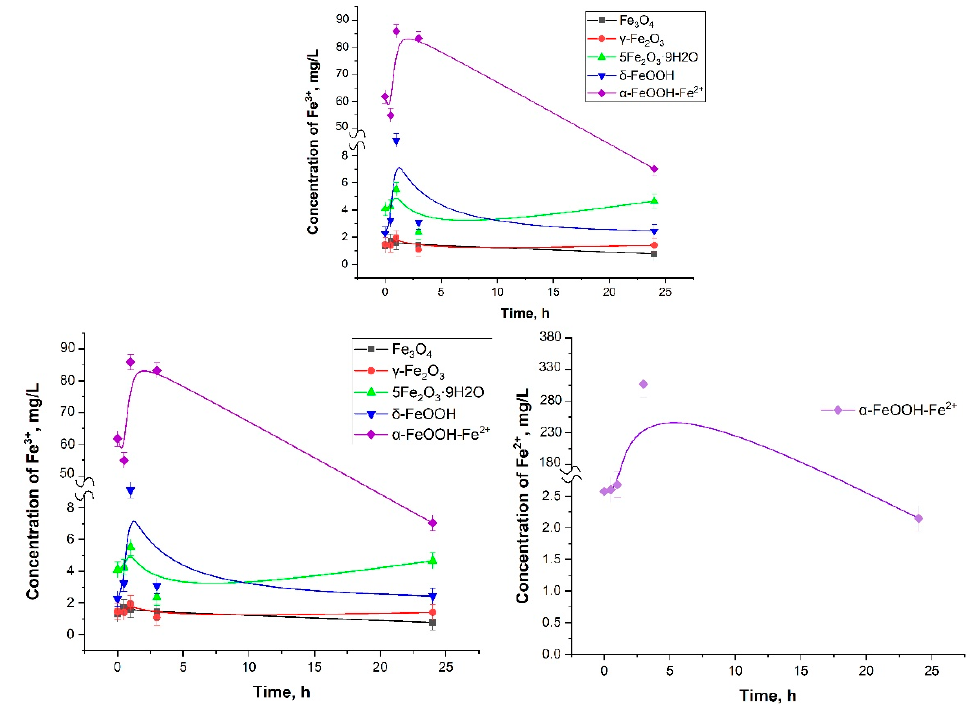
Figure 5. Fe 2+ and Fe 3+ ion release kinetics from Fe 3 O 4 , γ -Fe 2 O 3 , δ -FeOOH, 5Fe 2 O 3 · 9H 2 O, α -FeOOH nanoparticles (Fe 3 O 4 pH 7, γ -Fe 2 O 3 pH 6.6 α -FeOOH-Fe 2+ pH 6.9 δ -FeOOH pH 6.7, 5Fe 2 O 3 ·9H 2 O pH 6.9) (see Supplementary Materials Figure S2).